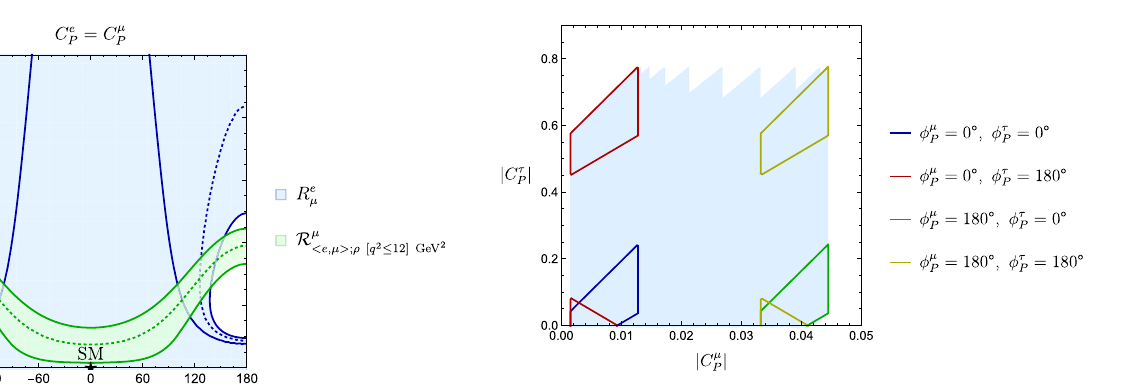
μ μ | plane from R e – | C P P